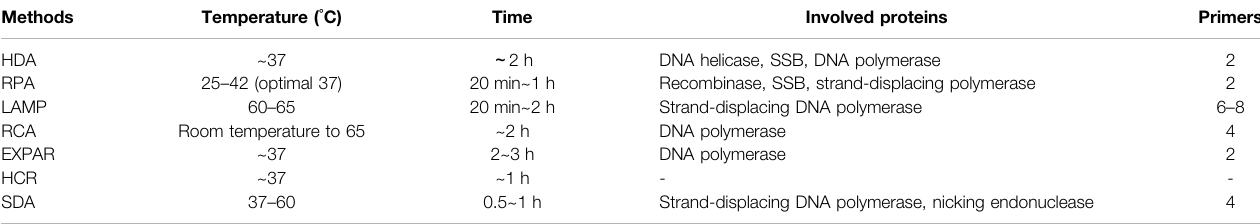
TABLE 2 | Comparison of isothermal ampli fi cation methods.